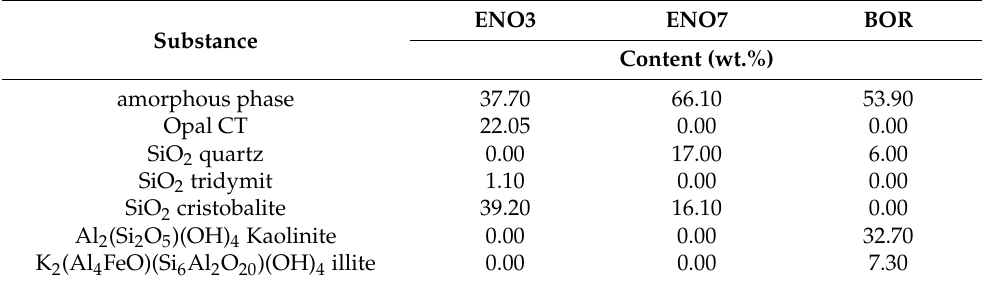
Table 2. XRD data of